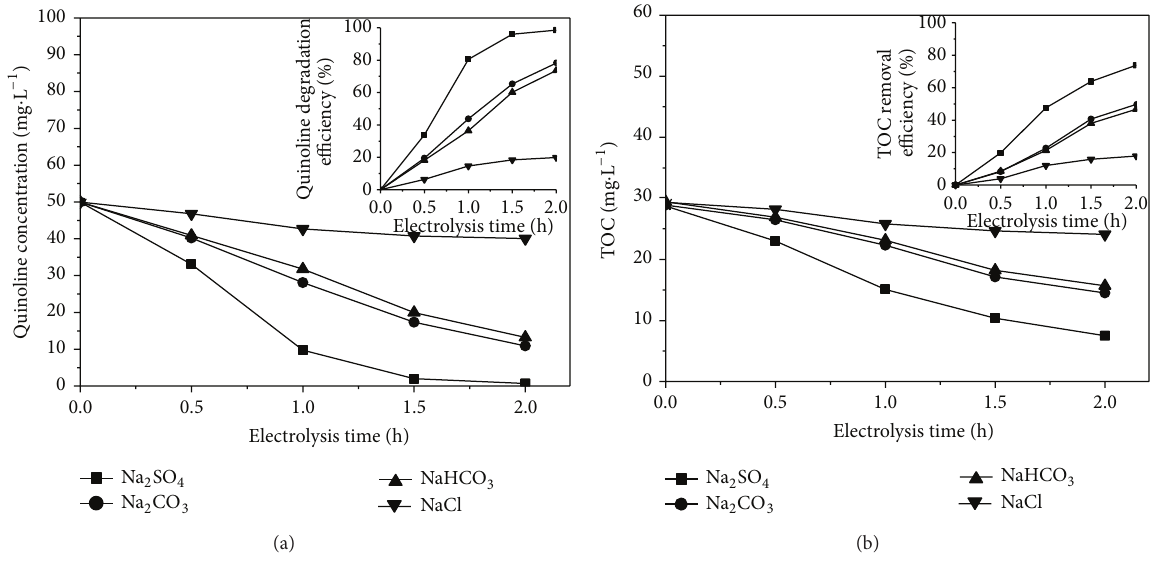
Figure 3: Effect of electrolyte type on quinoline degradation (a) and TOC removal